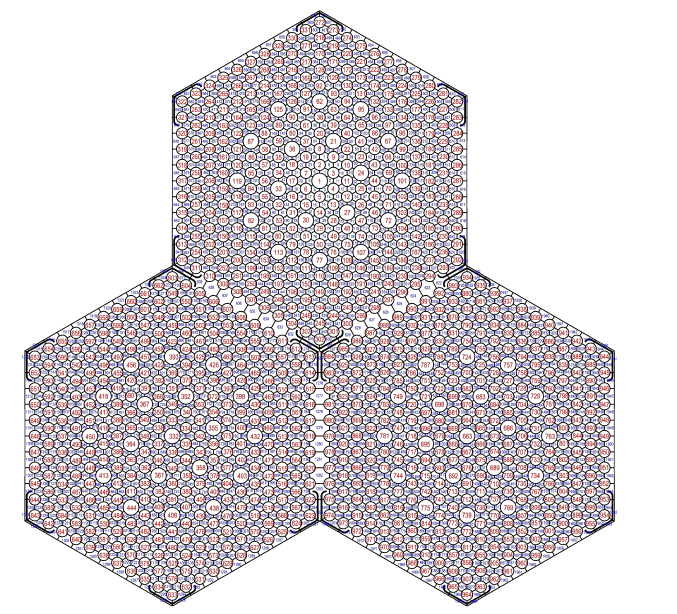
Figure 1. Three fuel assemblies model with rod and subchannel numbering.